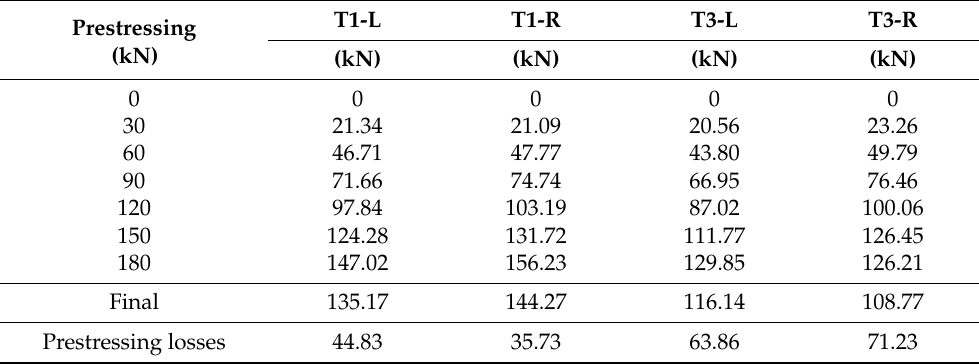
Table 3. Prestressing of strands T1 and